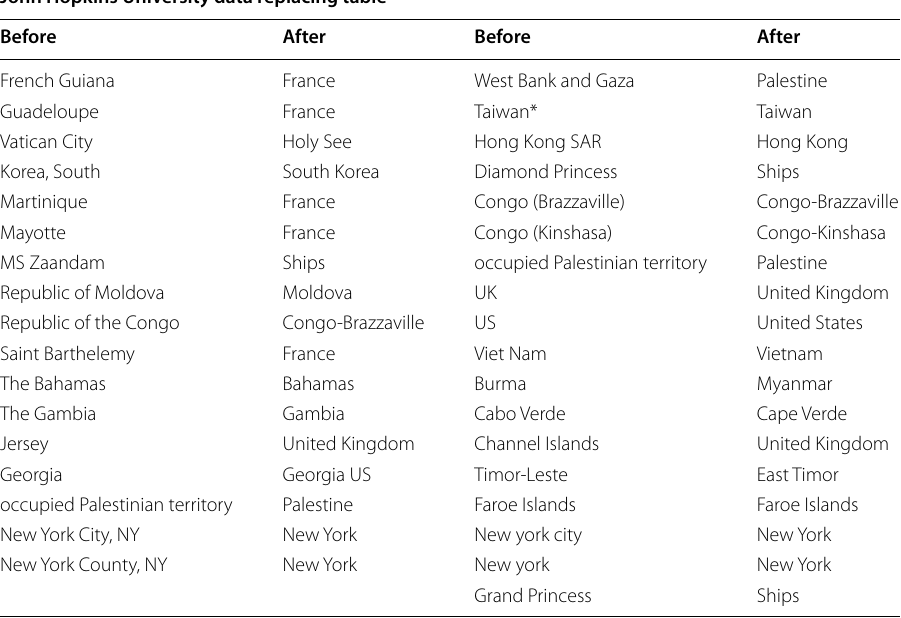
Table 1 John Hopkins University data replacing table John Hopkins University data replacing